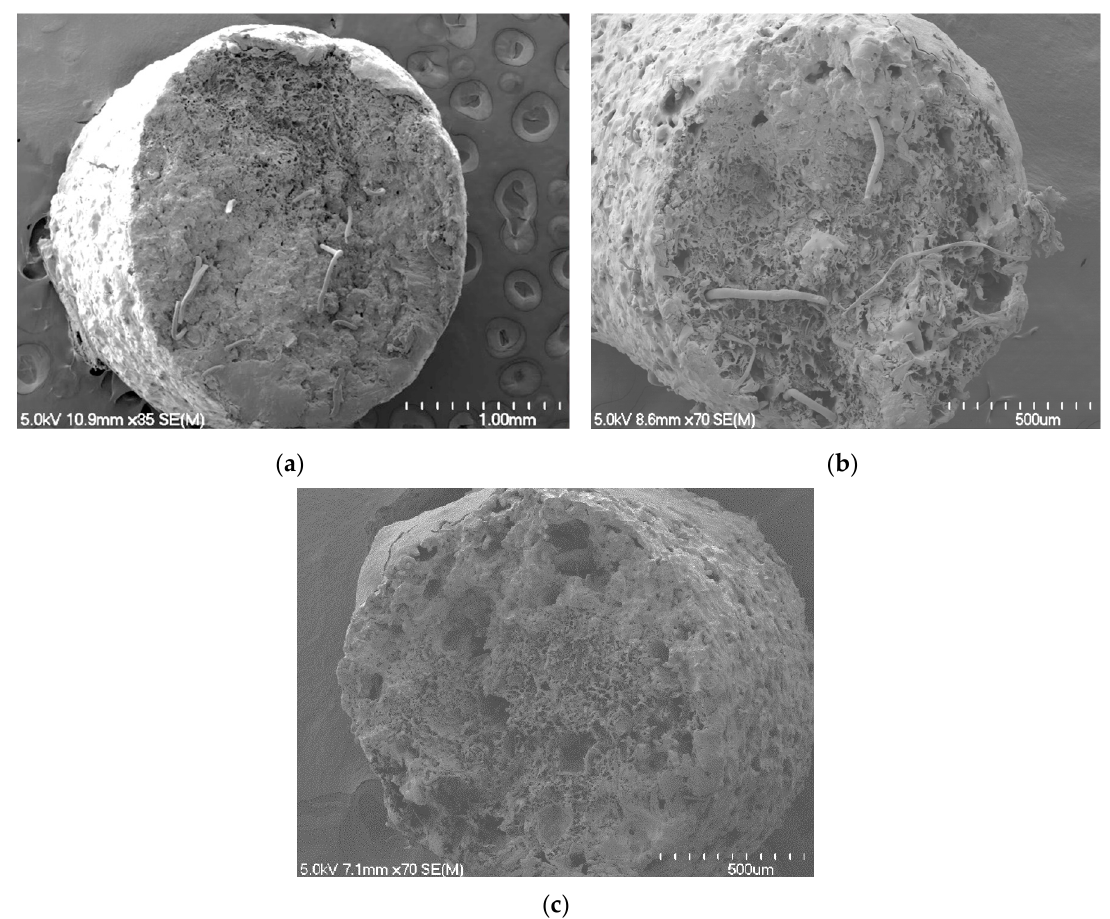
Figure 14. Fracture surfaces of ( a ) 3 mm printing filament, ( b ) 1 mm printed filament produced with pre-dried filament, and ( c ) 1 mm filament produced without pre-drying with 20 wt % harakeke.